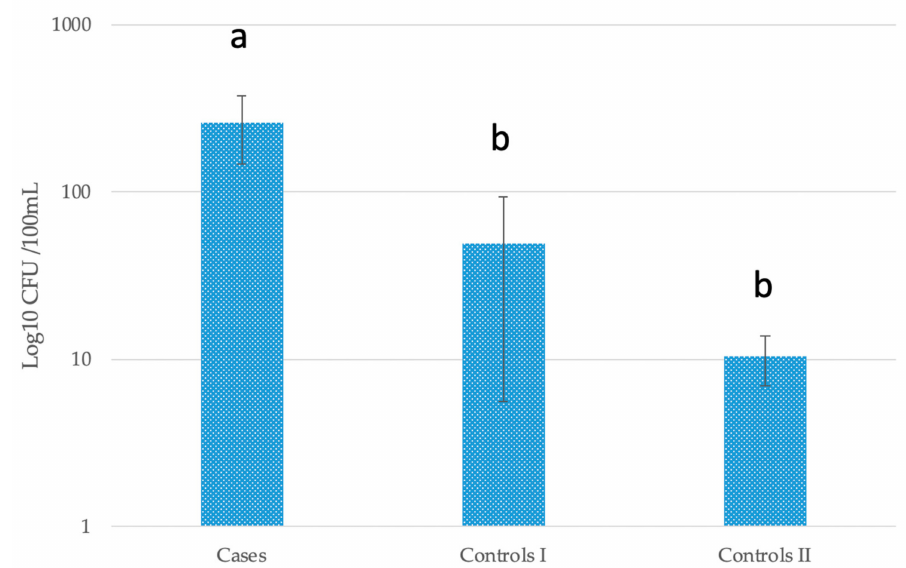
Figure 3. Mean most probable number (MPN) log 10 CFU of E. coli per 100 mL of drinking water stored by case and control households. Error bars = +/ − standard error. Sequential lettering above columns indicates significant di ff